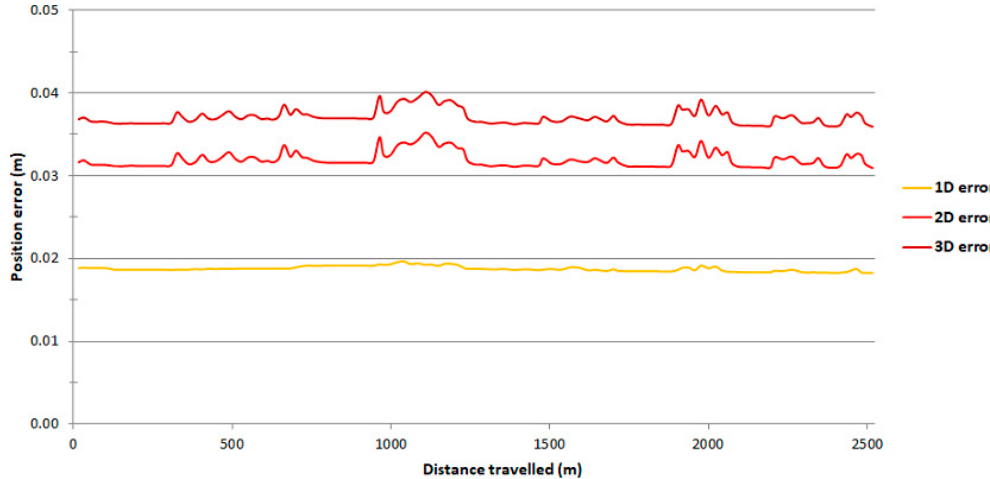
Figure 10. Variability of the 1D, 2D and 3D position errors recorded using the Ekinox2-U system in the RTK mode on route no. 2.